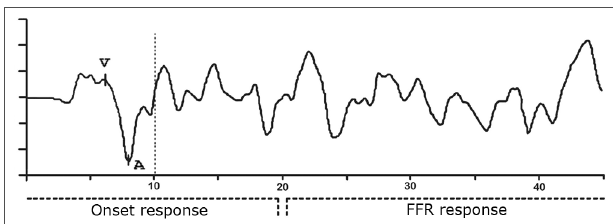
Chart 1. Representation of the Brainstem response for speech stimulus in an individual from the DT group in this